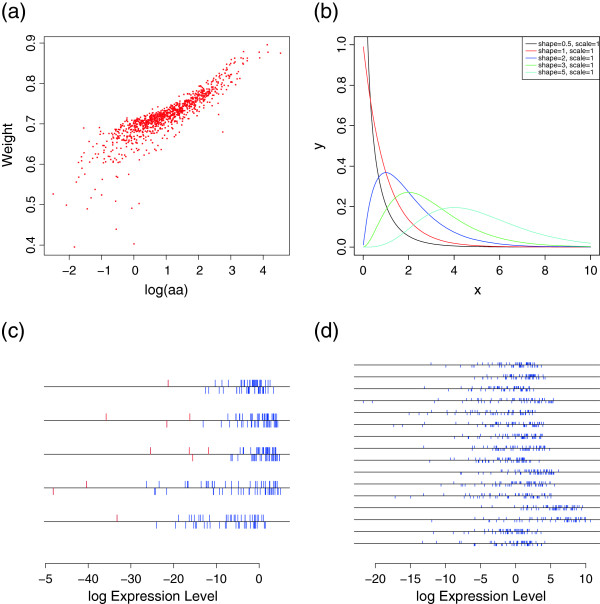
β-weights can diagnose a misspecified model. (a) Scatter plot of log(aa) versus β-weight. Many of the genes with a shape parameter (aa) less than 1 have small β− weights. (b) The true distribution of gamma for different values of the shape parameter when the value of scale parameter is one. (c) The log-transformed expressions based on genes between weight < 0.53 and log(aa) < -1 in (a) are plotted below the lines for group 2 tissues and above the lines for group 1 tissues. The genes with low β− weights were shown to have heavy lower tails. (d) The log-transformed expressions based on genes between weight ≥ 0.6 and log(aa) < -1 in (a) are plotted below the lines for group 2 tissues and above the lines for group 1 tissues. The log-transformed expression profiles of these genes were shown to be similar to the normal distribution.